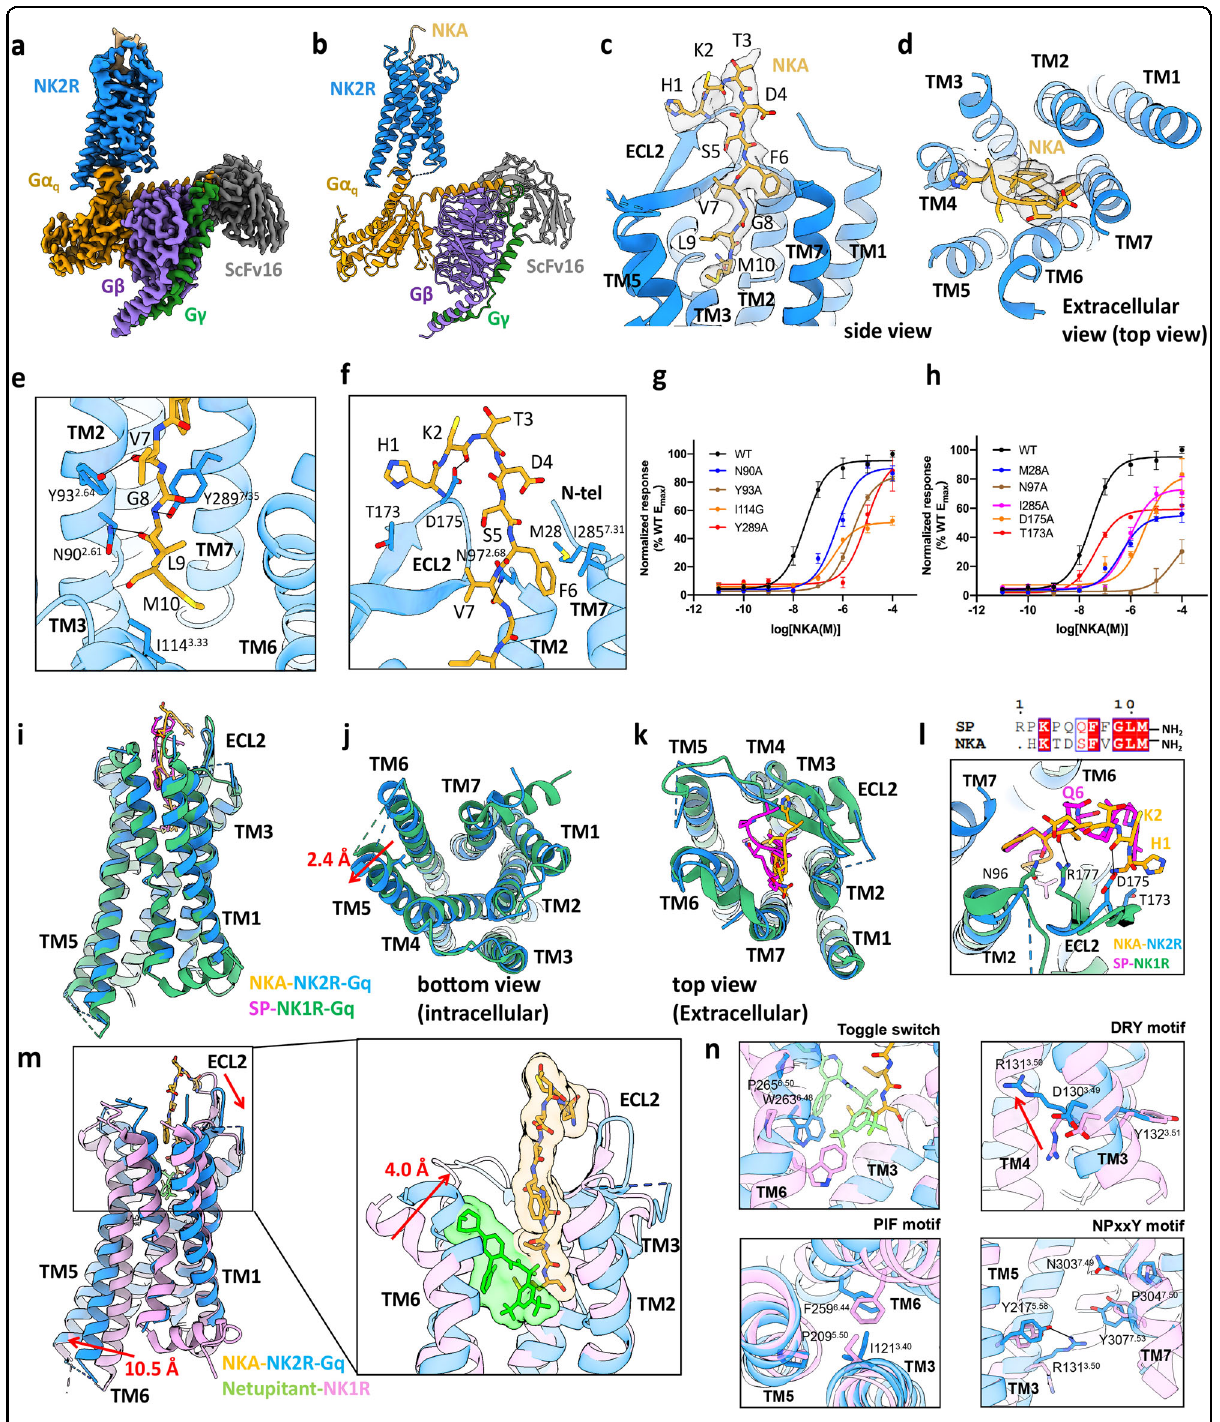
Fig. 1 Structural insights into the activation of NK2R by NKA. a , b Cryo-EM density map ( a ) and ribbon diagram representation ( b ) of NK2R – G q / NKA complex. c , d Side and top views of the ligand-binding pocket of NK2R – G q /NKA complex. e The polar interactions between the C-terminus of NKA and TMDs of NK2R. f Interactions between the N-terminus of NKA and the extracellular surface of NK2R. g , h Ca 2 + accumulation analysis of wild- type NK2R and mutants that interact with the C- ( g ) and N-termini ( h ) of NKA. i – k The side ( i ), bottom ( j ) and top ( k ) views of the comparison between the NKA-bound NK2R and the SP-bound NK1R structures. l Superimposition of the ECL2s of the NKA-bound NK2R and the SP-bound NK1R. m The comparison of the NKA-bound active-state NK2R (blue) and the antagonist netupitant-bound inactive-state NK1R (green) structures. n Conformational changes of toggle switch, PIF motif, DRY motif and NPxxY motif after NK2R activation upon binding of